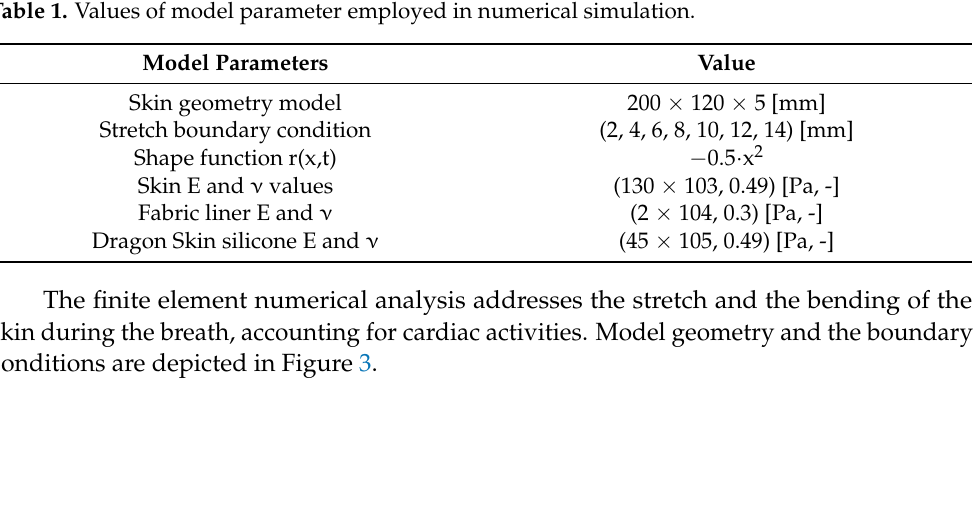
Table 1. Values of model parameter employed in numerical